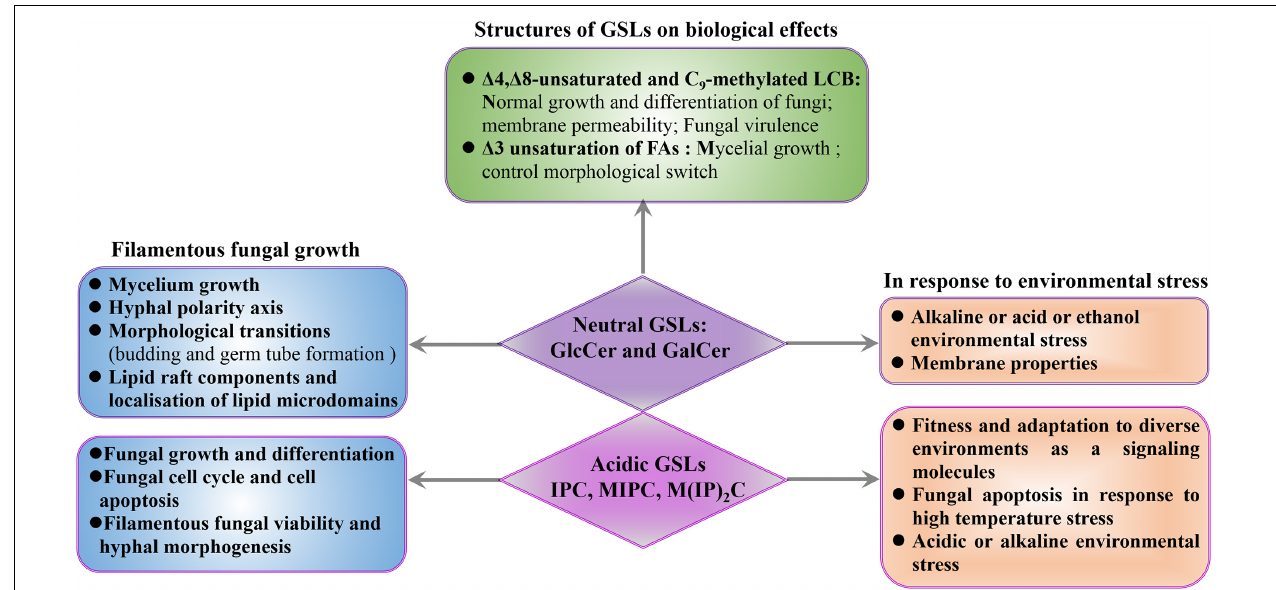
FIGURE 3 | Biological roles of GSLs in filamentous fungi. The effects of GSLs on filamentous fungi were discussed from three aspects, mainly including fungal growth and environmental stress. Meanwhile, the functions of the (cid:49) 3-unsaturated FAs, and (cid:49) 4, (cid:49) 8-unsaturated, and C9-methylated structures of GlcCer and GalCer were also